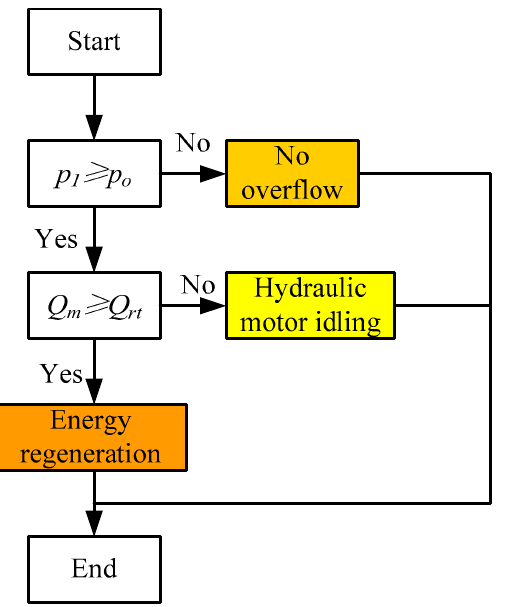
Figure 11. The control flow chart of energy regeneration system for the relief valve.